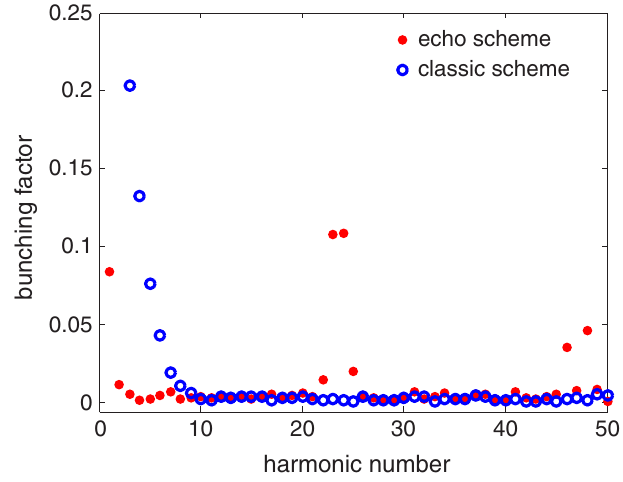
FIG. 7. (Color) Comparison of the bunching factors from the EEHG scheme (red dots) and that from the classic HGHG scheme (blue circles).